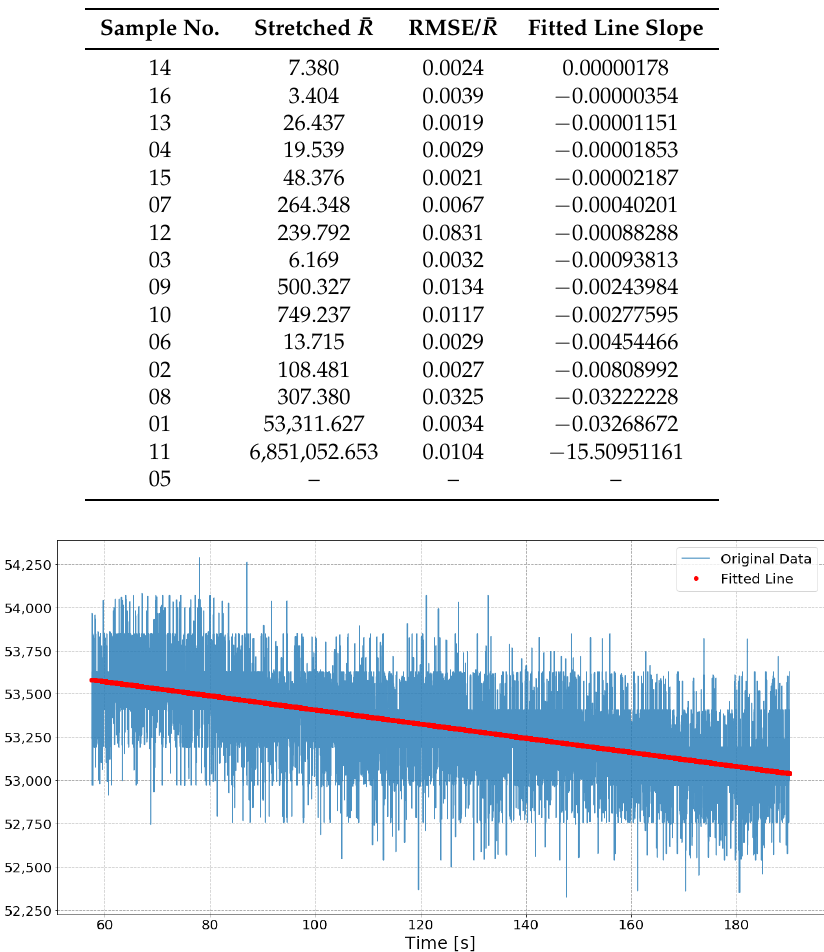
Table 8. Summary of sensors held at 70% strain (ranked by slope).